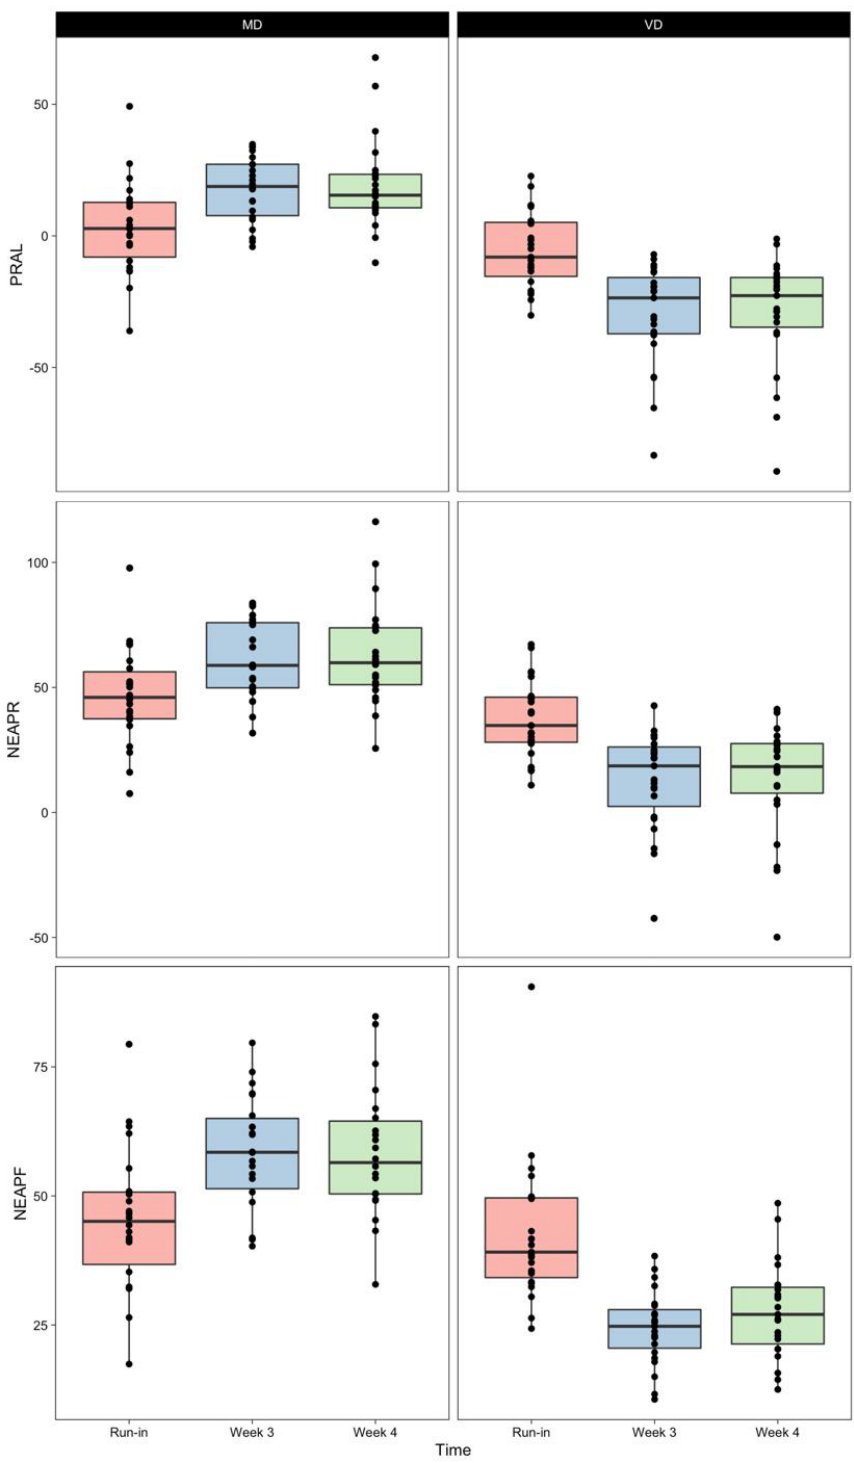
Figure 1. Box plots of DAL indexes PRAL, NEAP R and NEAP F calculated after the run-in phase (red), after 3 weeks of dietary intervention (blue) and after 4 weeks of dietary intervention (green) with either a meat-rich (MD) or a vegan diet (VD). Lower and upper hinges of the box plots delimit 25th and 75th percentiles. The middle line shows the median. Upper and lower whiskers extend from their respective hinges to the largest and lowest value, no further than 1.5 times the inter-quartile range, respectively.